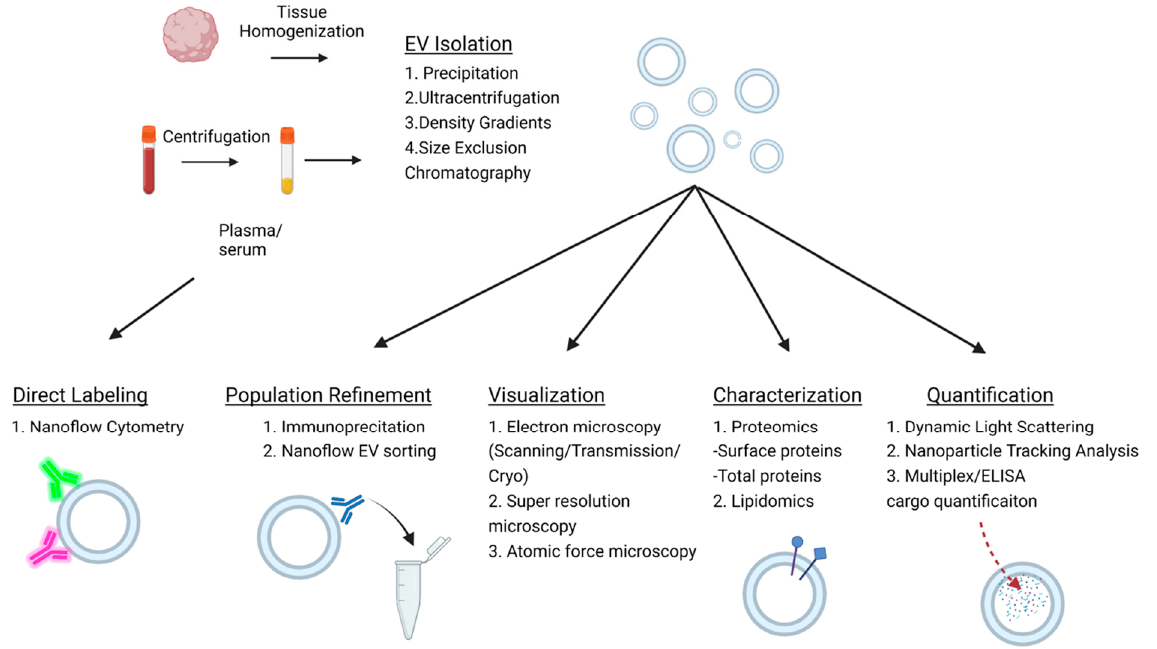
Figure 2. Methods of EV isolation and quantification. Schematic depicting commonly used methods for EV analysis. EVs can be measured in tissue homogenates or various biological fluids of interest (saliva, urine, blood, etc.). Plasma/serum isolation from blood is used here as an example. Using nanoflow cytometry, EVs can be directly labeled and quantified in fluids. Alternatively, EVs can be isolated and subjected to downstream analysis. Immunoprecipitation can be used to refine EV populations, EVs can be visualized using EM or other high-resolution microscopy approaches, and both lipidomics and proteomics can be used to characterize EV populations. Finally, quantification of EV concentration and size is possible with dynamic light scattering and nanoparticle tracking analysis while EV cargo can be quantified with sensitive protein or RNA assays. Created with BioRen- der.com.